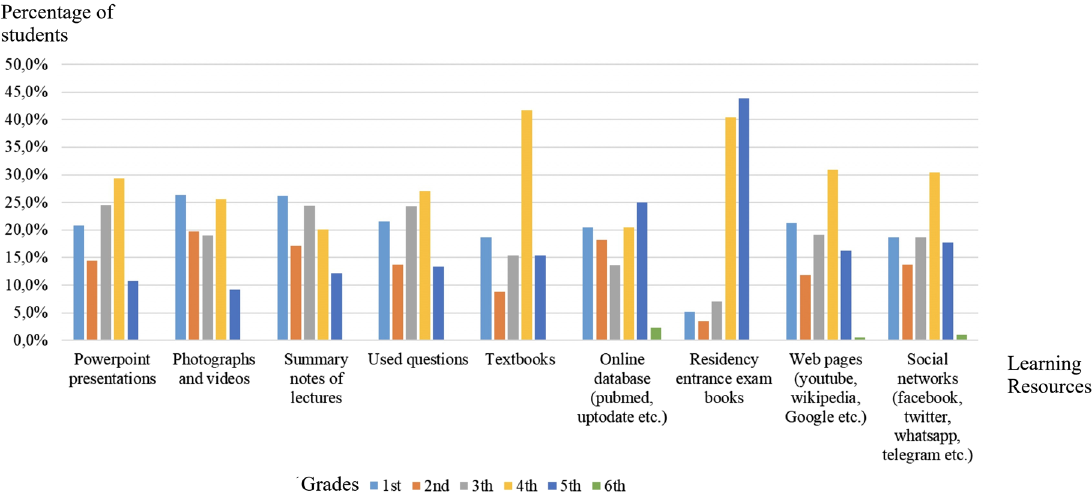
Figure 2: Distribution of students ’ use of learning resources.